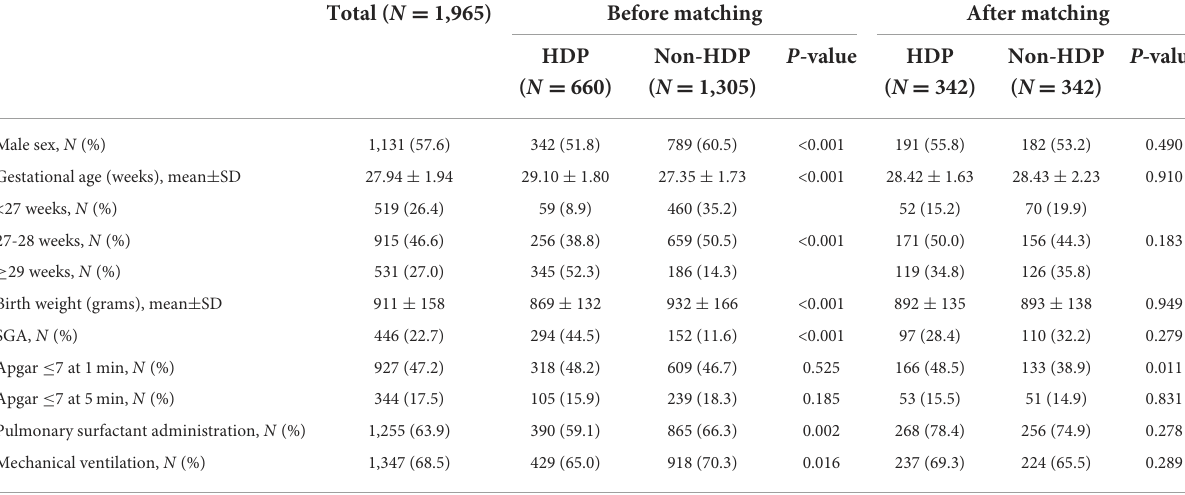
TABLE 1 The neonatal characteristics in HDP and non-HDP groups.